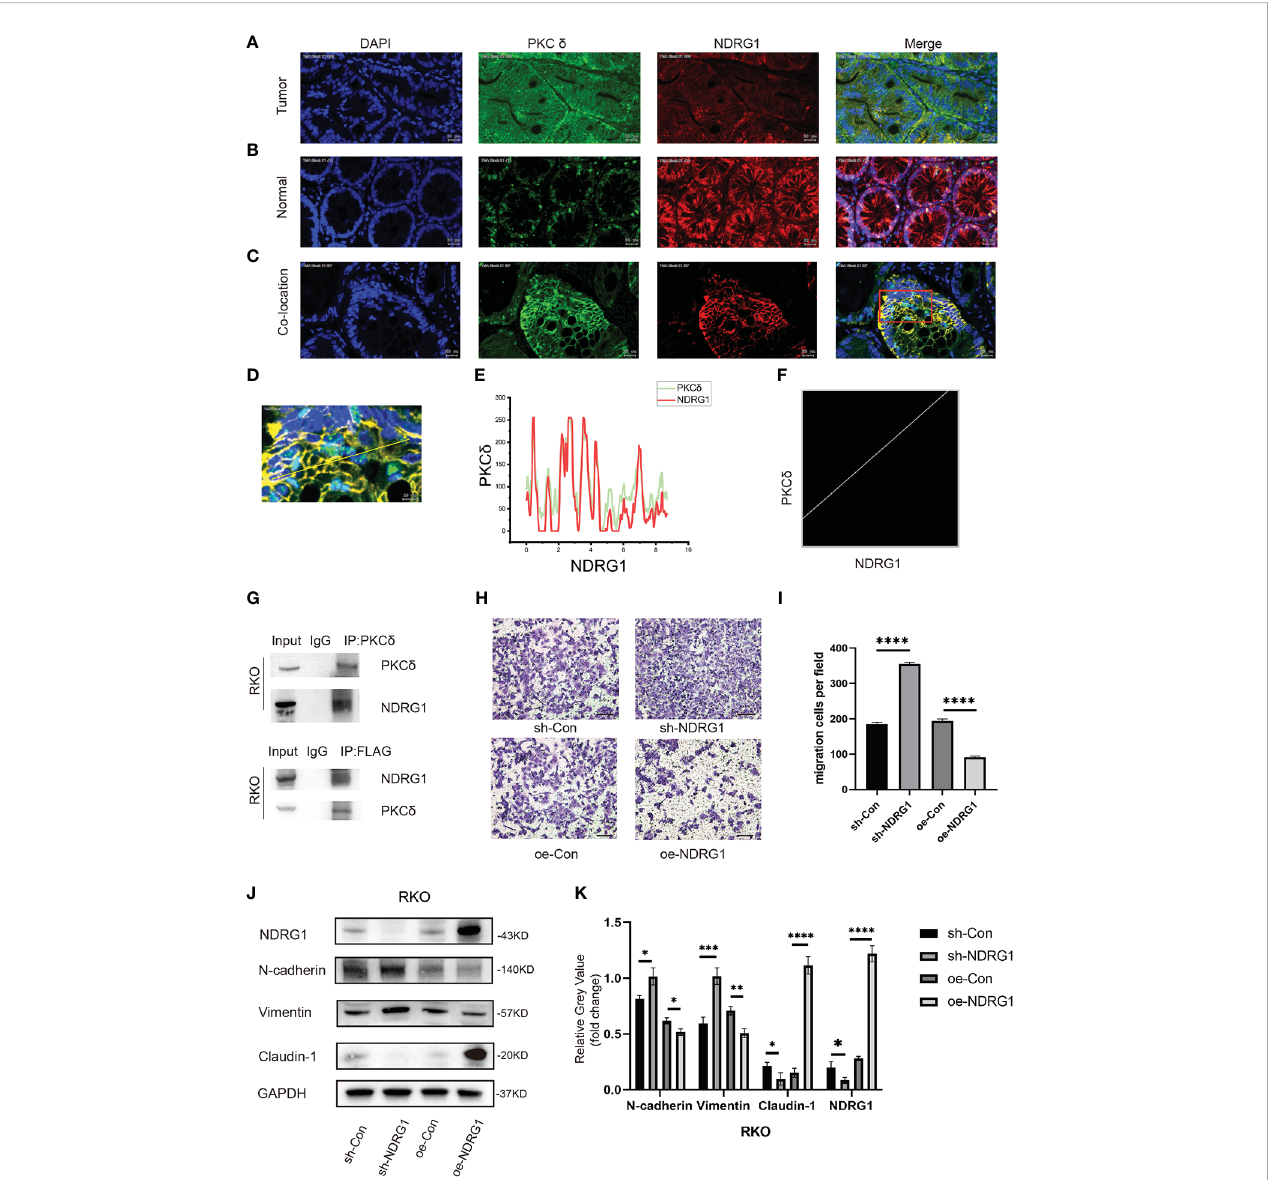
FIGURE 5 PKC d and NDRG1 were co-located in CRC tissues. (A) The expression of PKC d and NDRG1 in CRC tumor tissues, detected by immuno fl uorescence histochemistry. (B) The expression of PKC d and NDRG1 in colorectal normal tissues, detected by immuno fl uorescence histochemistry. (C) The typical immuno fl uorescence images of PKC d and NDRG1 in CRC tumor tissues for co-localization analysis. (D) Enlarged view of the image in the red box, which indicated the co-localization of PKC d and NDRG1 in CRC, with the pixel acquisition area by the yellow line, detected by immuno fl uorescence histochemistry. (E) Pixel loci analysis of the expression of PKC d and NDRG1 in colorectal cancer. (F) Analysis of the co-localization relationship of PKC d and NDRG1 in CRC by software Fiji Image J, with the Pearson ’ s R-value 0.80, which indicated that PKC d and NDRG1 were co-located strongly in CRC. (G) Co-immunoprecipitation was used to detect the relationship of PKC d and NDRG1. (H) NDRG1 inhibited the migration of CRC cells by cell migration assay. (I) Columns were used to quantify the migrated and invasive cells in (H) . (I) Knocking down NDRG1 downregulated the epithelial marker Claudin-1 and upregulated the mesenchymal marker N-cadherin and Vimentin expression, while overexpression of NDRG1 showed the opposite trend in RKO cells, determined by Western blots. (K) Columns were used to quantify the protein expression in (J) relative to GAPDH. Scale bar. 20µm.* p < 0.05, ** p < 0.01, *** p < 0.001, **** p <